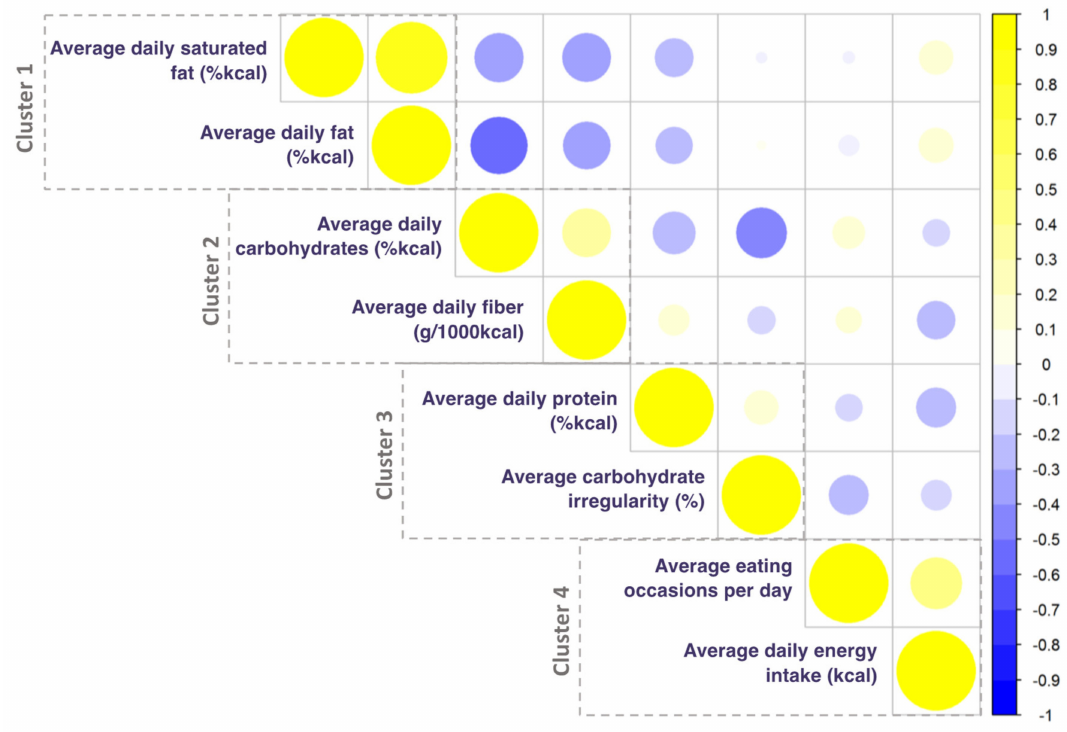
Figure 3. Correlation matrix of top two diet exposures for k-means 4- cluster solution. Yellow indicates a positive correlation coe ffi cient; blue indicates a negative correlation coe ffi